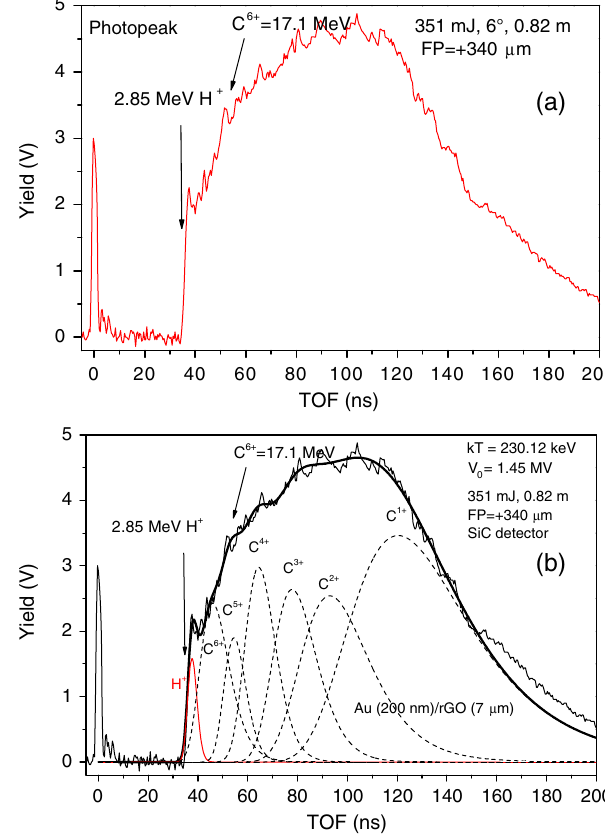
FIG. 3. SiC-TOF spectrum relative to the maximum ion acceleration (a) and peak deconvolution for protons and carbon ions using the CBS distribution function (b).